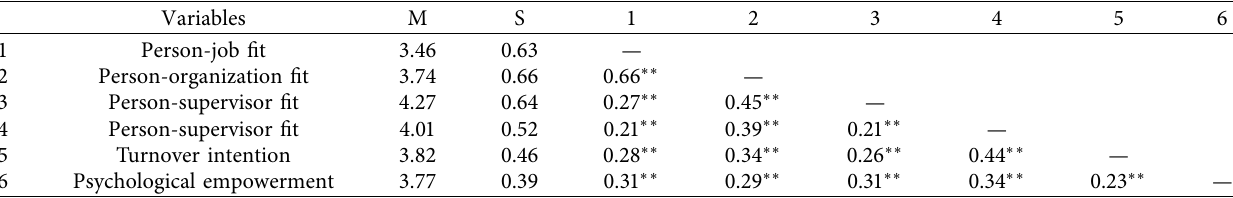
Table 1: Summary of means, standard deviations, and correlations of all variables.